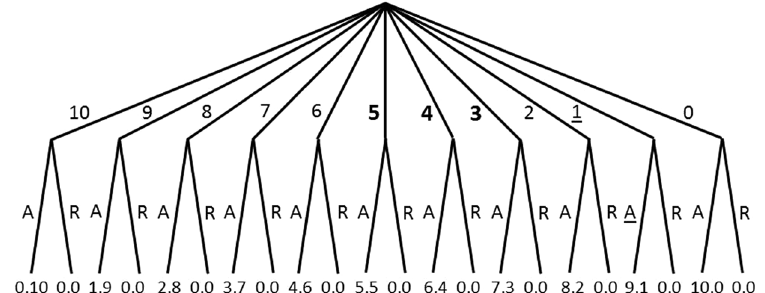
Figure 1. Game tree for an UG with 10 € being the total amount and 1 € being the smallest unit. The proposer chooses her strategy first and has (in this special game) 11 options. Offers are given by the numbers at the upper branches. The responder chooses second, with A and R standing for “accept” and “reject”, respectively. Payoffs are indicated below the lower branches in the sequence proposer, responder. Underlined options “1, A” correspond to the subgame-perfect Nash equilibrium. Any strategy pair “offer p , accept p and reject every lower offer” with p > 10% is not subgame-perfect because after the proposer had offered 1 (i.e. 10%), rejecting that would not be the best choice by the responder at that stage, that is, in the resulting subgame. Offers indicated in bold are empirically the most frequent ones and are usually accepted. The offer “4” is nearest to the GR in